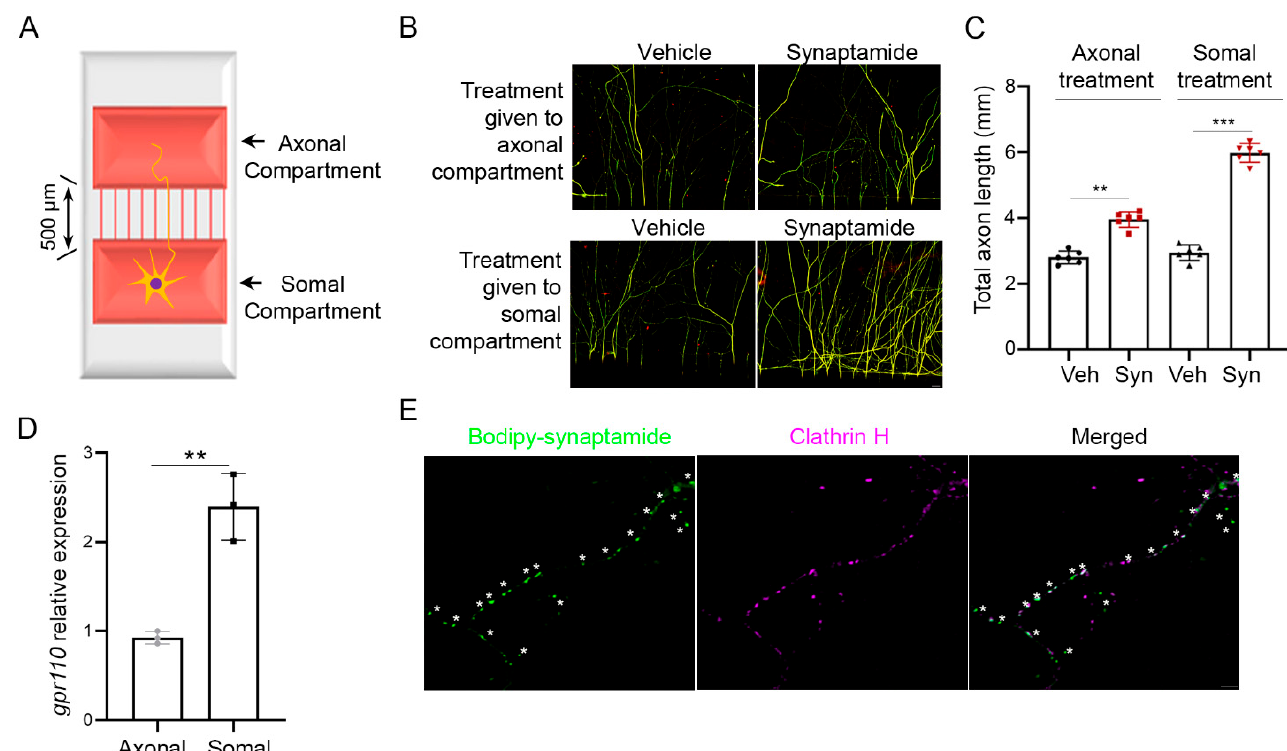
Figure 1. Axon growth promoted by either somal or axonal treatment of synaptamide. ( A ) Schematic representation of a microfluidic culture platform with two chambers separated by 500 µ m of thin grooves that was used to culture primary cortical neurons from the mouse brain at postnatal day 0 (P0). ( B ) β -III tubulin immunofluorescence micrographs showing that axon outgrowth in primary cortical neurons was induced by the application of 10 nM synaptamide to the axonal or somal compartment on DIV3 and cultured for an additional 4 days. ( C ) Quantitative results of the total length of axons entered in the axonal compartment. Synaptamide application to the cell body or axonal compartment resulted in a 2.2- or 1.3-fold increase in axon growth, respectively, compared to the vehicle control. ( D ) Relative quantification of gpr110 expression in soma and axon determined by RT-PCR after collecting samples separately from the somal or axonal compartment of the two-chamber culture platform. ( E ) Internalization of GPR110 visualized by a fluorescent ligand bodipy–synaptamide. After 30 min stimulation of DIV 3 cortical neurons with 20 nM bodipy-synaptamide, internalized GPR110 was detected as fluorescent endocytic puncta (green) overlapping with an endocytic marker clathrin H (magenta), confirming the axonal presence of GPR110. Asterisks (*) represent endocytic GPR110 receptor puncta. Data are expressed as mean ± s.e.m. with n = 6 for ( B ) and n = 3 for ( D ) per group. ** p < 0.01, *** p < 0.001 by t -test; Veh, Vehicle (DMSO); Syn, synaptamide. Scale bar, 20 µ m ( B ), 1 µ m ( E ).